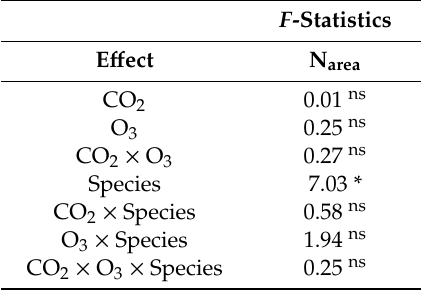
Figure 4. Area-based leaf N content (N arae ) in the seedlings of Japanese oak ( Q. mongolica ) and Konara oak ( Q. serrata ) grown under ambient ( A -O 3 ) and elevated O 3 ( E -O 3 ), combined with ambient ( A -CO 2 ) and elevated CO 2 ( E -CO 2 ). Values are means ± se ( n = 3). Table 2. F values of three-way ANOVA with two between-subjects factors (CO 2 and O 3 ) and one within-subject factor (species), to test the e ff ects of CO 2 ( F 1,8 ), O 3 ( F 1,8 ), species ( F 1,8 ), CO 2 × O 3 ( F 1,8 ), CO 2 × Species ( F 1,8 ), O 3 × Species ( F 1,8 ), and CO 2 × O 3 × Species ( F 1,8 ) on area-based leaf nitrogen content (N area ). The symbols ns and * denote non-significant ( p > 0.05) and significant ( p ≤ 0.05) e ff ects,